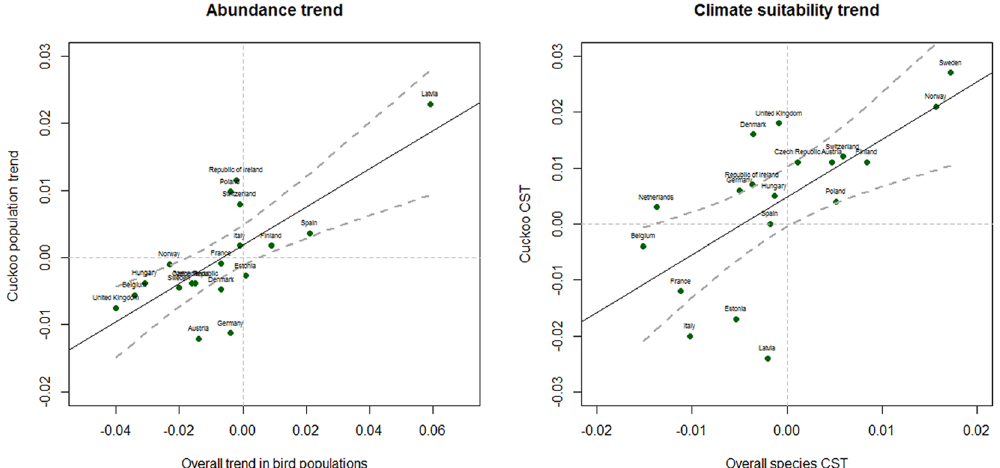
Figure 3. Correlation between cuckoo population trend and overall trend of bird populations (left panel) and cuckoo climate suitability trend (CST) and overall CST of birds (right panel) in ten European countries. The bird population trends and bird CST in Europe were obtained from Stephens et al . 14 . The lines are linear regression lines and 95% confidence